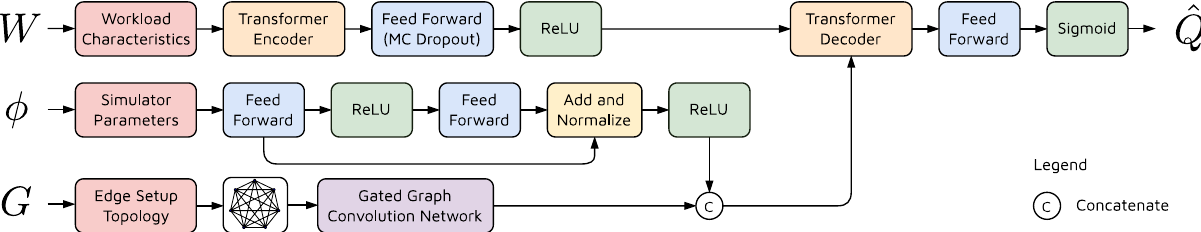
Figure 3. Low-Fidelity surrogate of the simulator in SimTune in the form of a neural network. The inputs include workload characteristics as time-series values, simulator parameters and edge topology as a fully- connected graph. The output is a vector of QoS